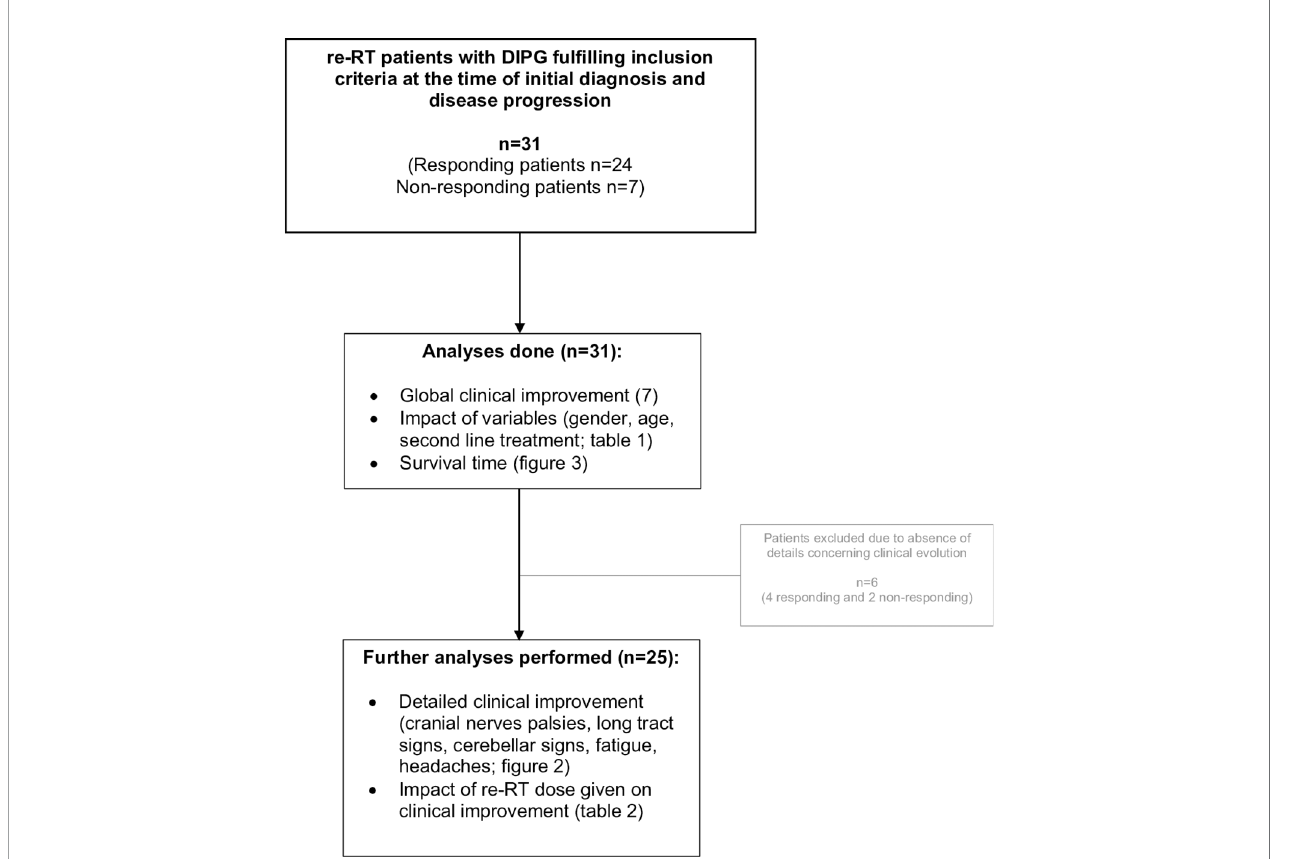
FIGURE 1 | Study diagram and analyses